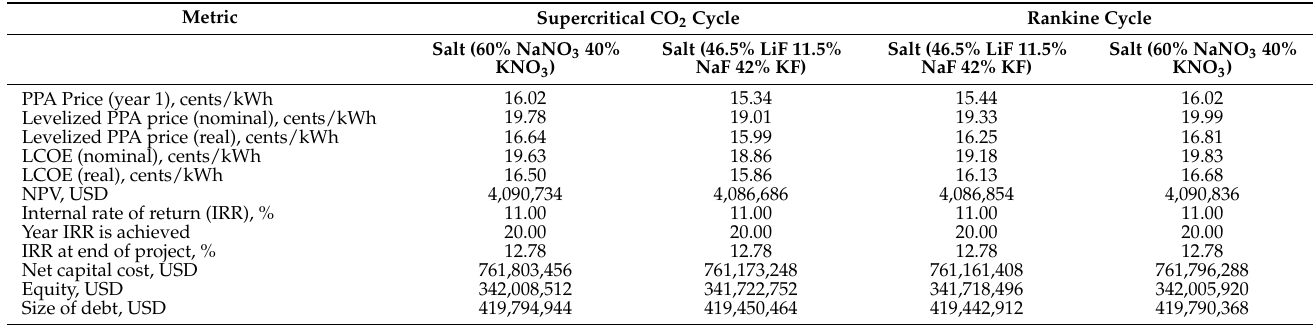
Table 3. Economic results for the various scenarios.